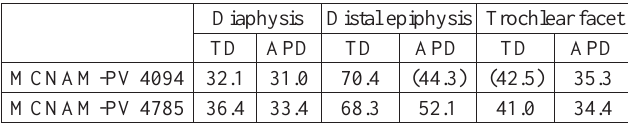
Table 4. Measurements (in mm) of the tibial fragments of Gualta cuy- ana from Quebrada Fiera, Mendoza. APD, anteroposterior diameter; TD, transversal